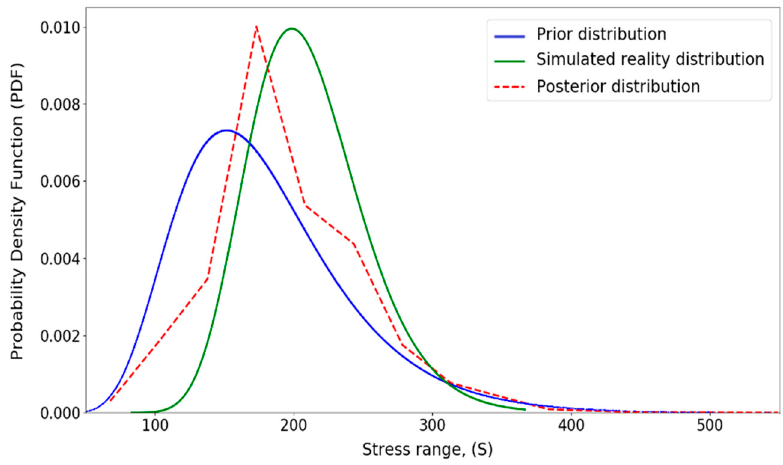
Figure 17. Updated distribution for crack growth parameter (C).